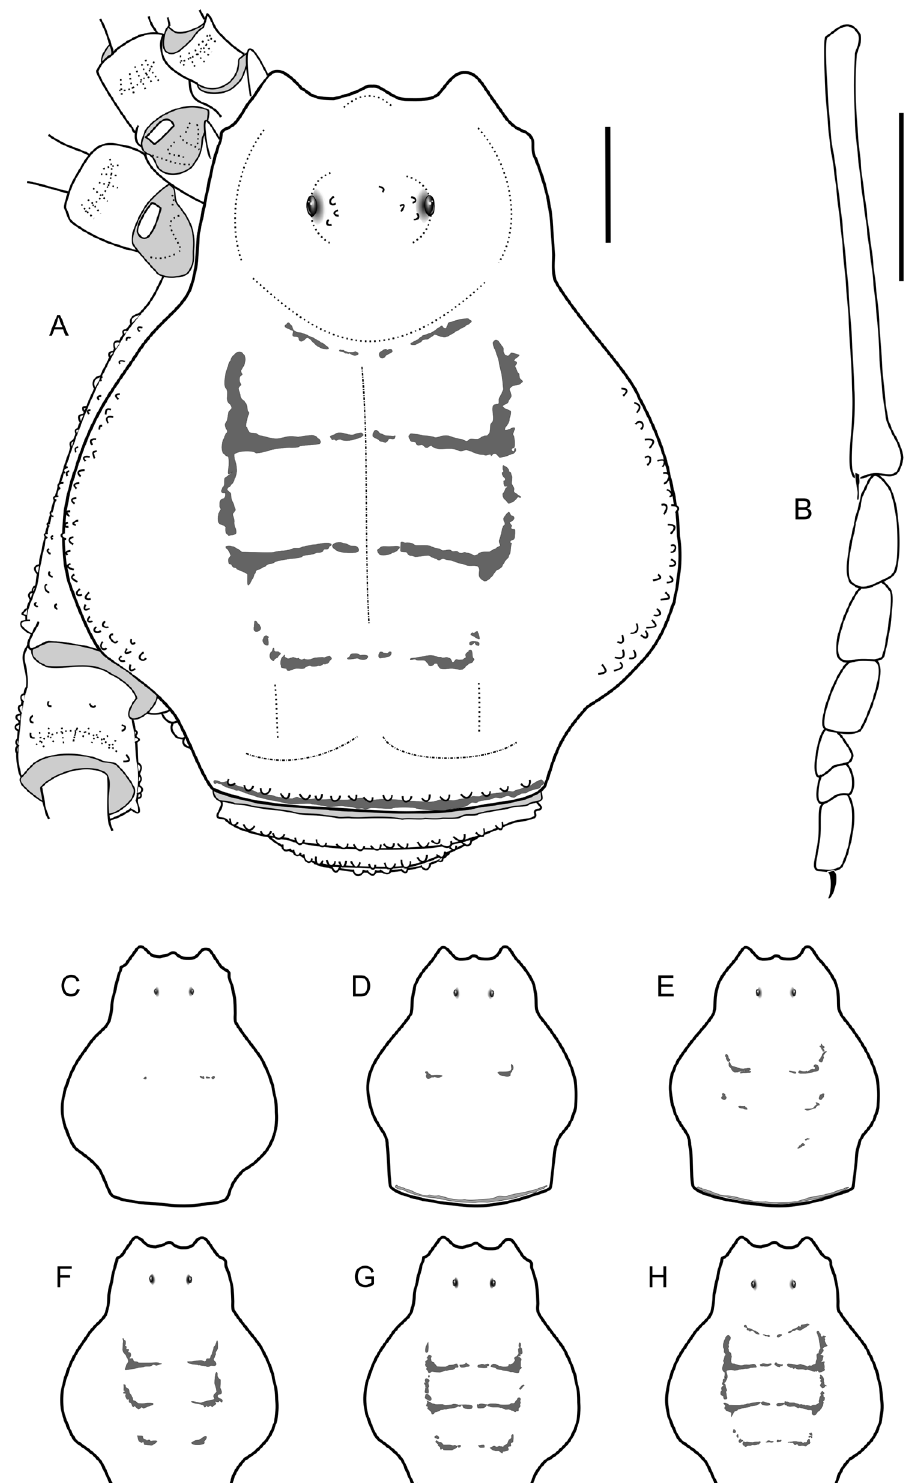
Fig. 20. Eulibitia maculata Roewer, 1912. A . Habitus, dorsal view, ♂ (ICN-AO 93). B . Left metatarsus and tarsomeres of leg I, prolateral view (ICN-AO 93). C – H . Variation of spot pattern on dorsal scutum. C . ♂ (ICN-AO 784). D . ♀ (ICN-AO 100). E . ♀ (ICN-AO 875). F . ♂, holotype (SMF 471). G – H . ♂♂ (ICN-AO 93). Scale bars: 1